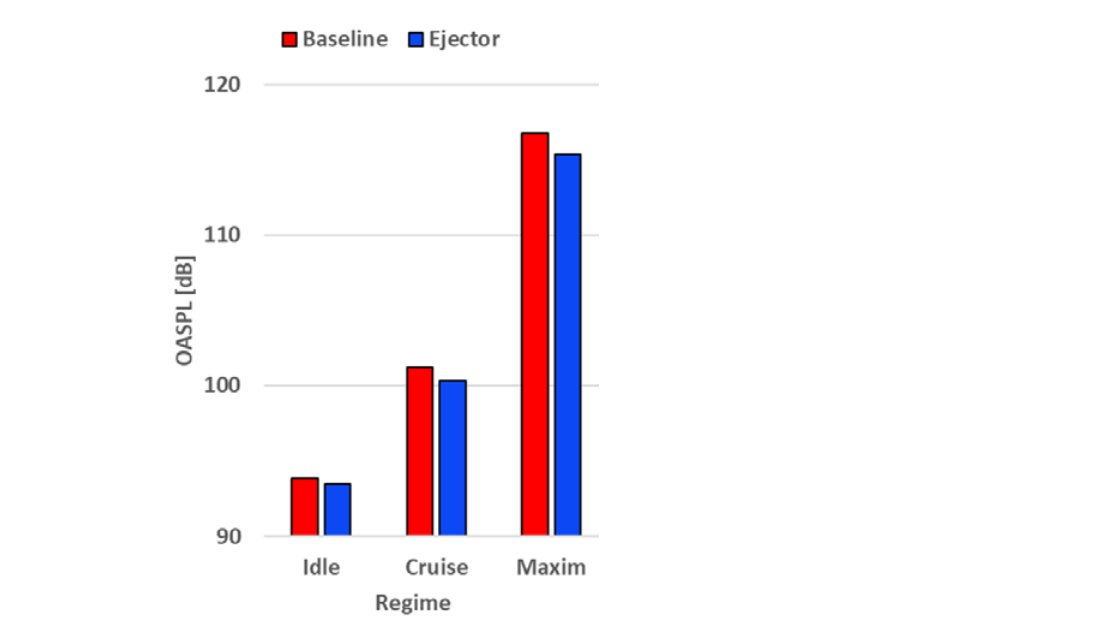
Figure 23. Averaged noise spectra for each configuration and regime.